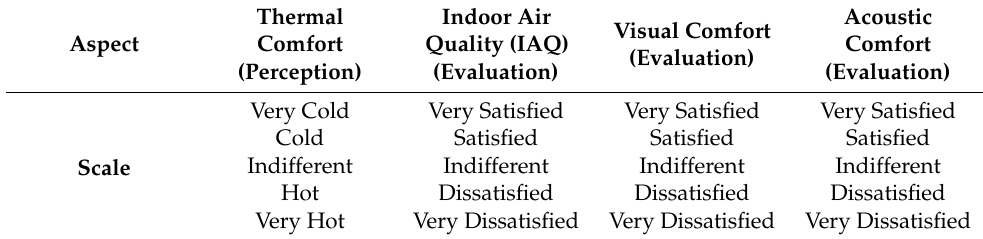
Visual Comfort (Evaluation)